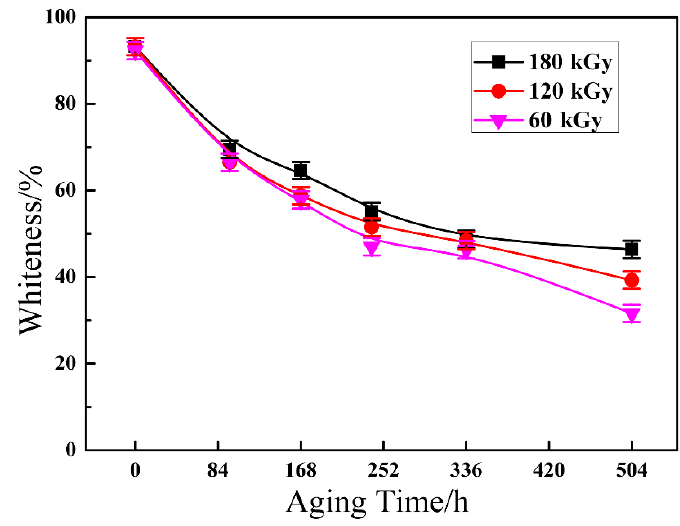
Figure 3. Whiteness as a function of aging time.